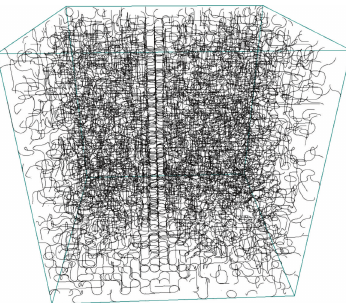
Figure 5: Initial string network configuration from the Vachaspati- Vilenkin algorithm. The box is a small lattice of 25 (cid:15) c for illustration purpose only.